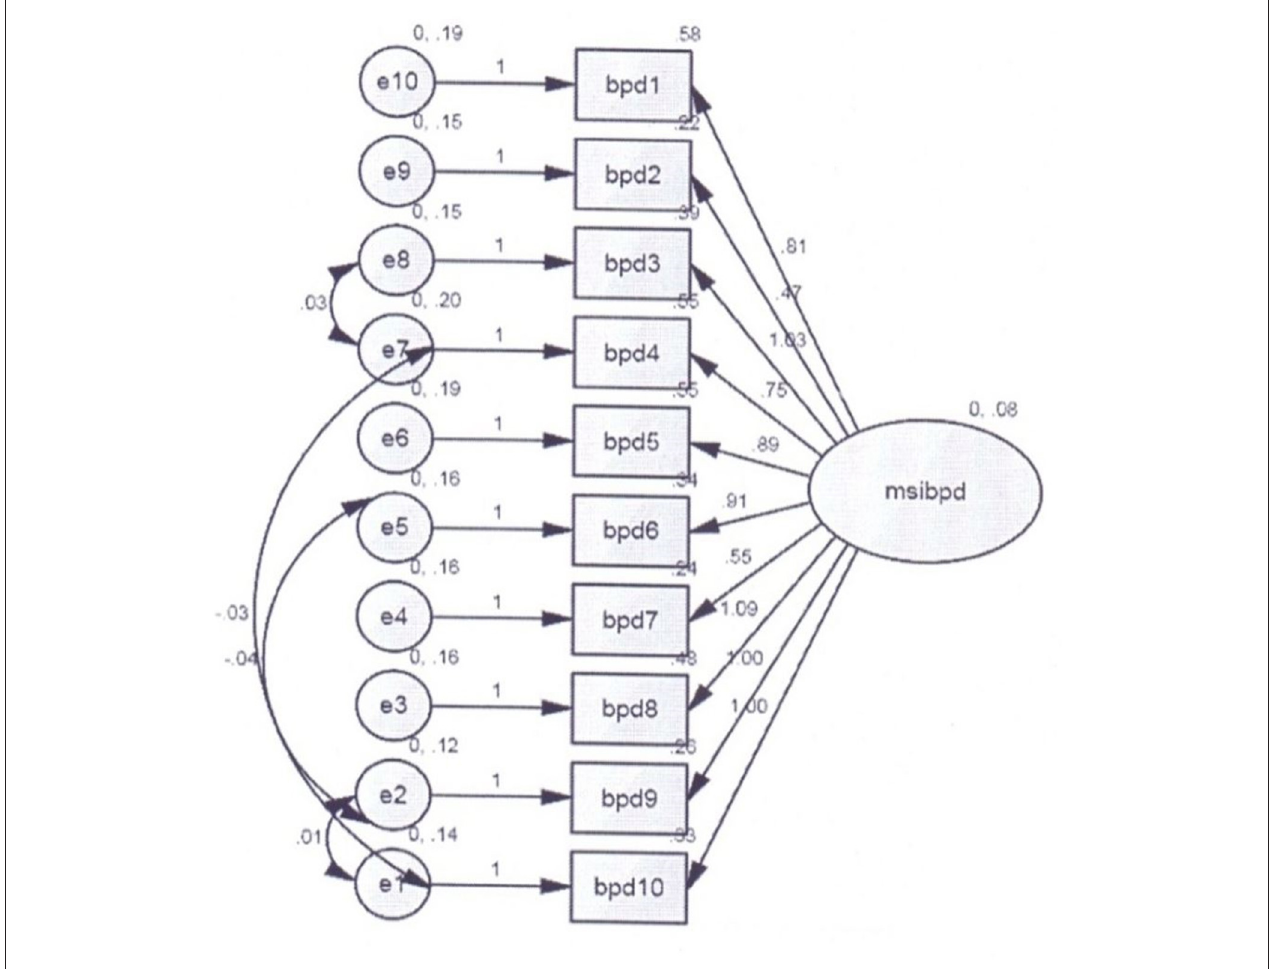
FIGURE 1 | Confirmatory factor analysis for the Urdu McLean Screening Instrument for Borderline Personality Disorder